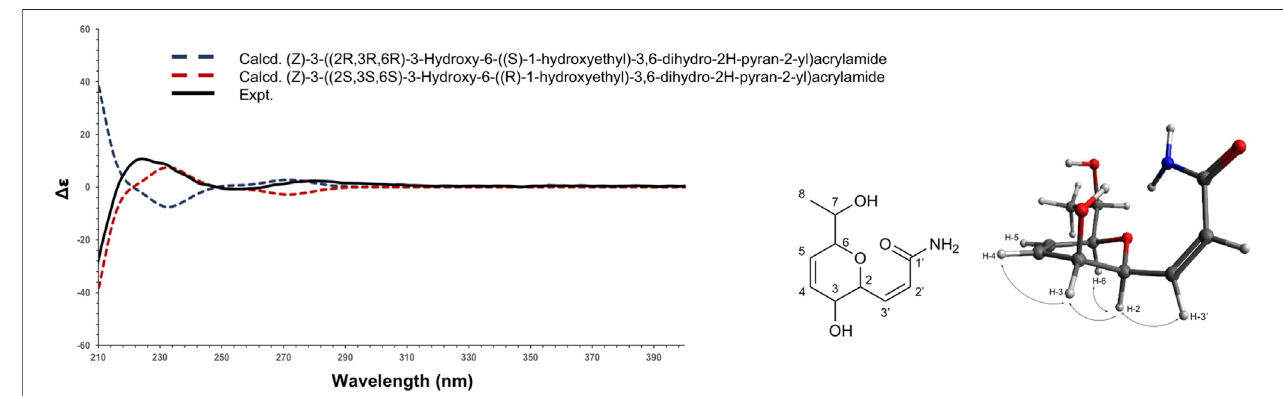
FIGURE 4 | Experimental (black) and TFT-TD-calculated ECD spectra of the two enantiomers (2 R ,3 R ,6 R ), (( S )-1-hydroxyethyl) (blue), and (2 S ,3 S ,6 S ), (( R )-1- hydroxyethyl) (red) of compound 1.